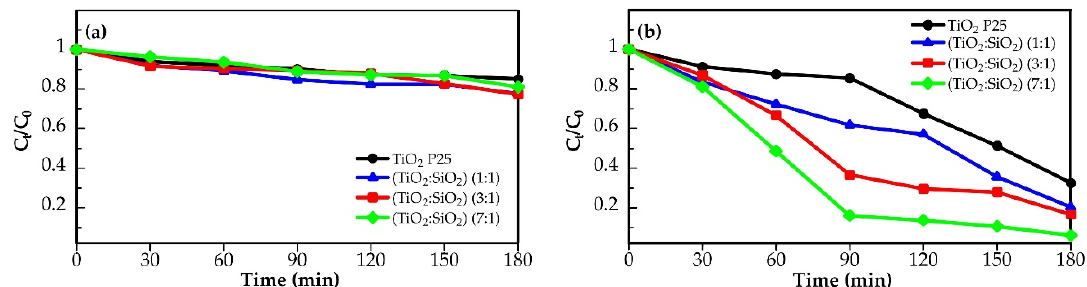
Figure 5. ( a ) Adsorption activity and; ( b ) Photocatalytic activity of catalyst on Cr(VI). The experiment was conducted using 100 mL Cr(VI) ion solution 3 mg / L and 100 mg catalyst with 180 min treatment.